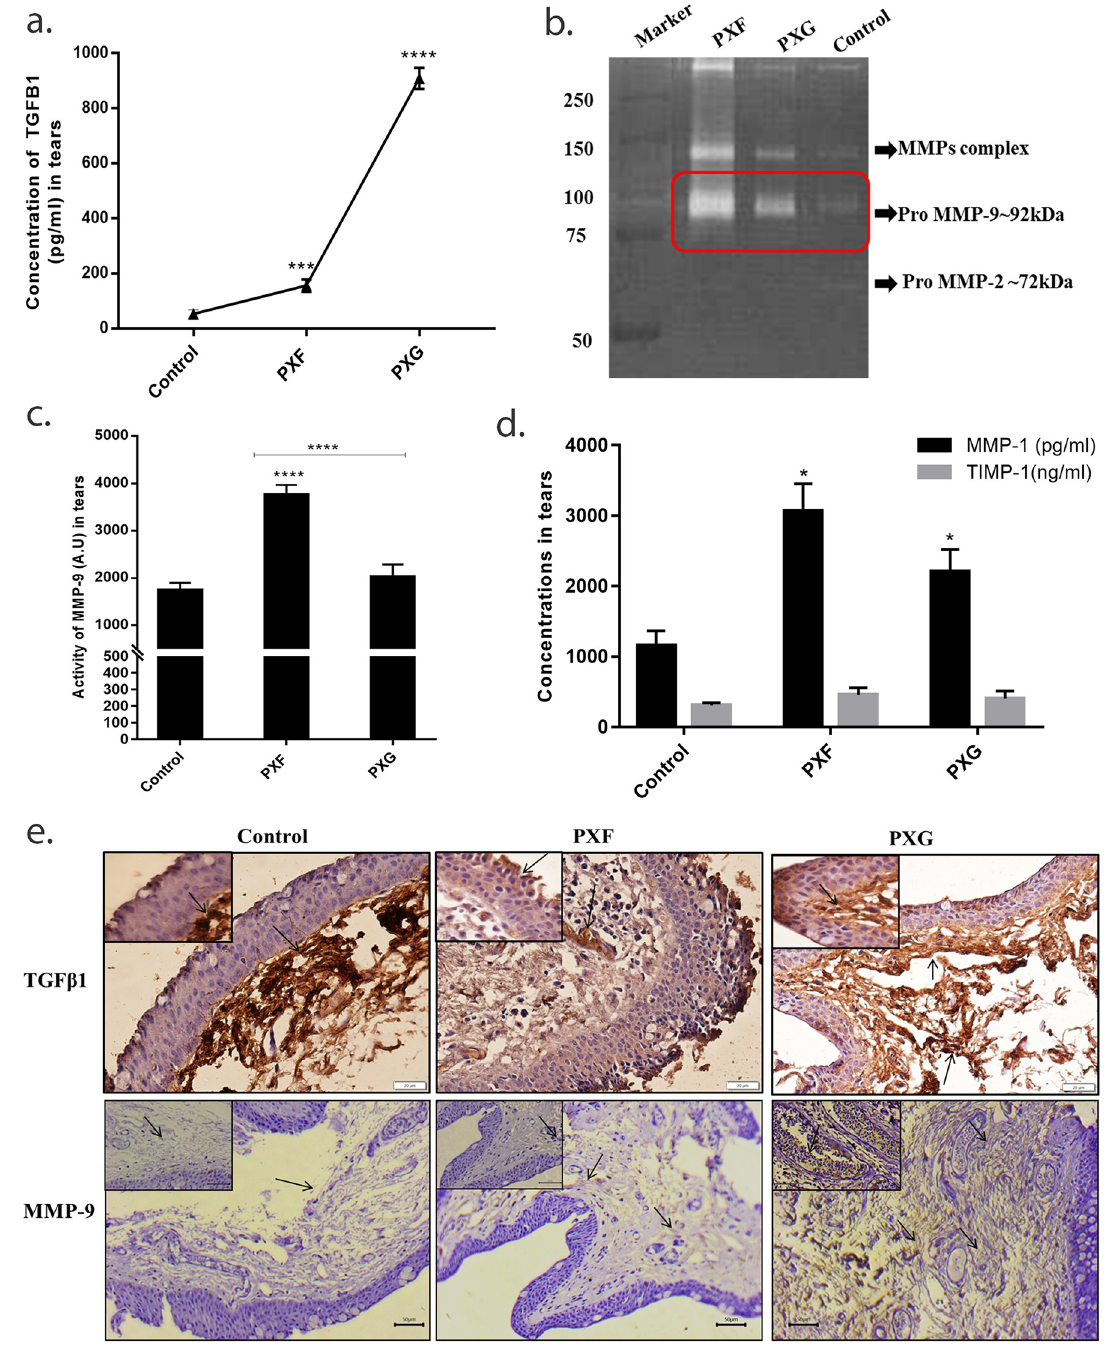
Fig 1. Expression/activity of TGF β 1, MMPs/TIMPs in tears, tenon’s capsule in different stages of pseudoexfoliation. a, concentration of TGF β 1 in tears (n = 6) using enzyme linked immunoassay; b and c, representative image and graph showing expression of MMP-9 in tears (n = 50) using gelatin zymography; d, concentration of TIMP-1 and MMP-1 in the 10 pooled tears in one (n = 20) by enzyme linked immunoassay; e, bright field microscopic images at × 20 and × 40 (inset) magnifications of TGF β 1 and MMP-9 in tenons capsule (n = 5) using imunohistochemical study. Scale bar-20um, 50um, Means ± SEM shown, � p < 0.05, ��� p < 0.001, ���� p < 0.0001 one way ANOVA post hoc t test with Turkey correction, PXF- pseudoexfoliation, PXG- pseudoexfoliation glaucoma.